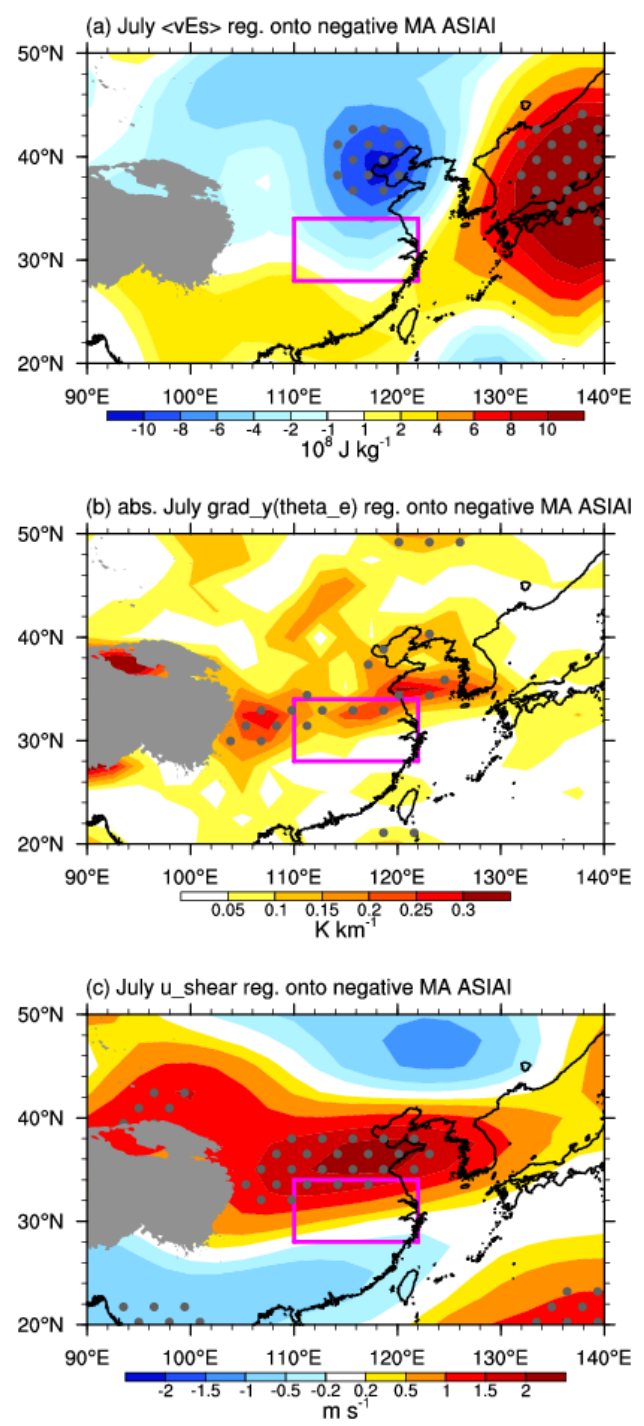
Figure 8. Regression pattern of July–mean ( a ) vertically integrated vEs (shading; unit: 10 8 J kg − 1 ); ( b ) absolute 850 hPa equivalent potential temperature gradient (shading; unit: K km − 1 ); and ( c ) vertical wind shear (differences between zonal wind at 200 hPa and 850 hPa; shading; unit: m s − 1 ), with regard to the normalized negative MA–mean ASIAI for the period 1980–2016. Regression coefficients that are significant at the 90% confidence level are stippled. The gray shaded area denotes the Tibetan Plateau. The magenta box denotes the research domain of the YHRB Meiyu region.